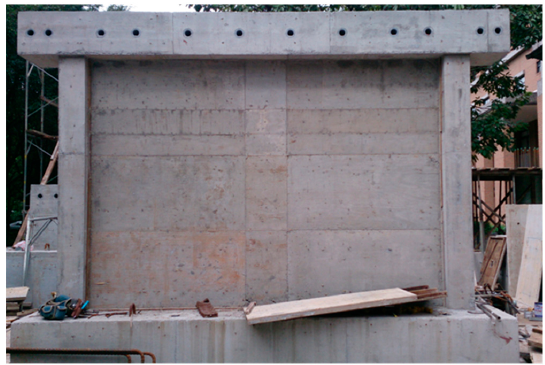
Figure 2. The front view of the specimen RCW1. Table 2. Concrete compressive strength of the specimens (unit: MPa).